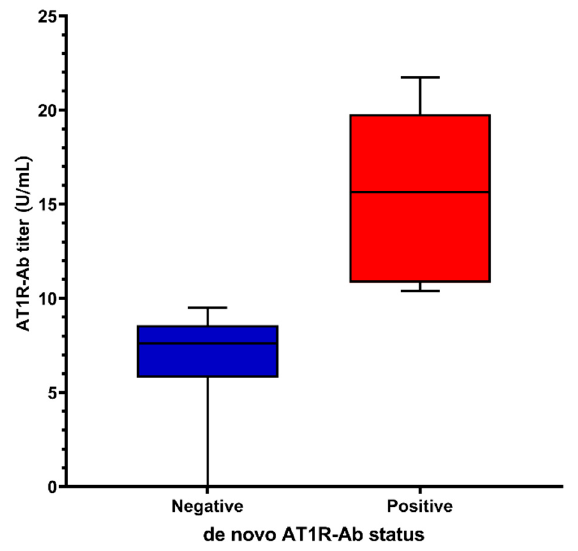
Figure 2. Antibody titers in positive and negative de novo AT1R-Ab groups.